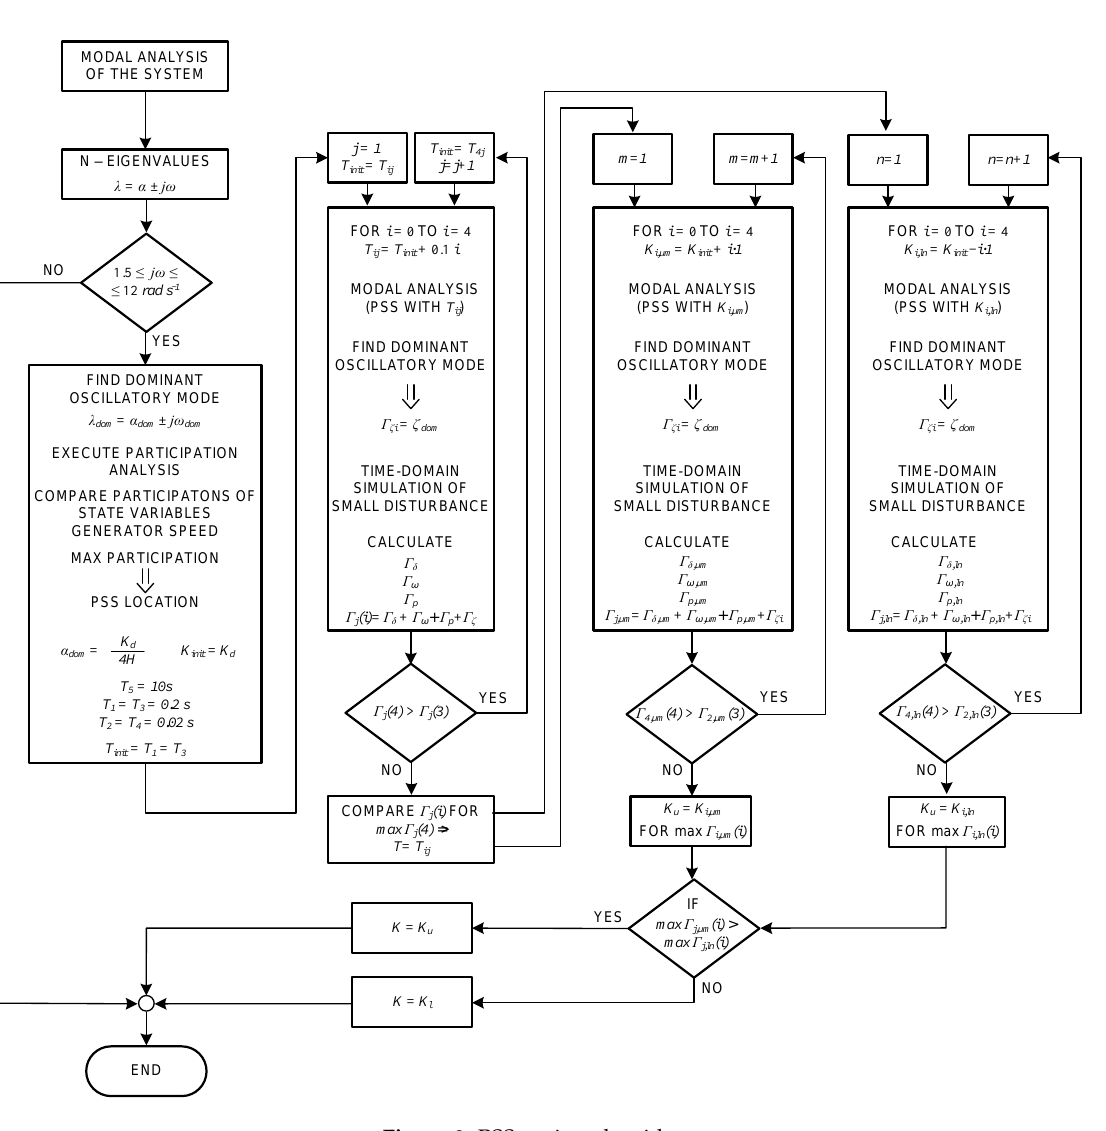
Figure 3. PSS tuning algorithm.